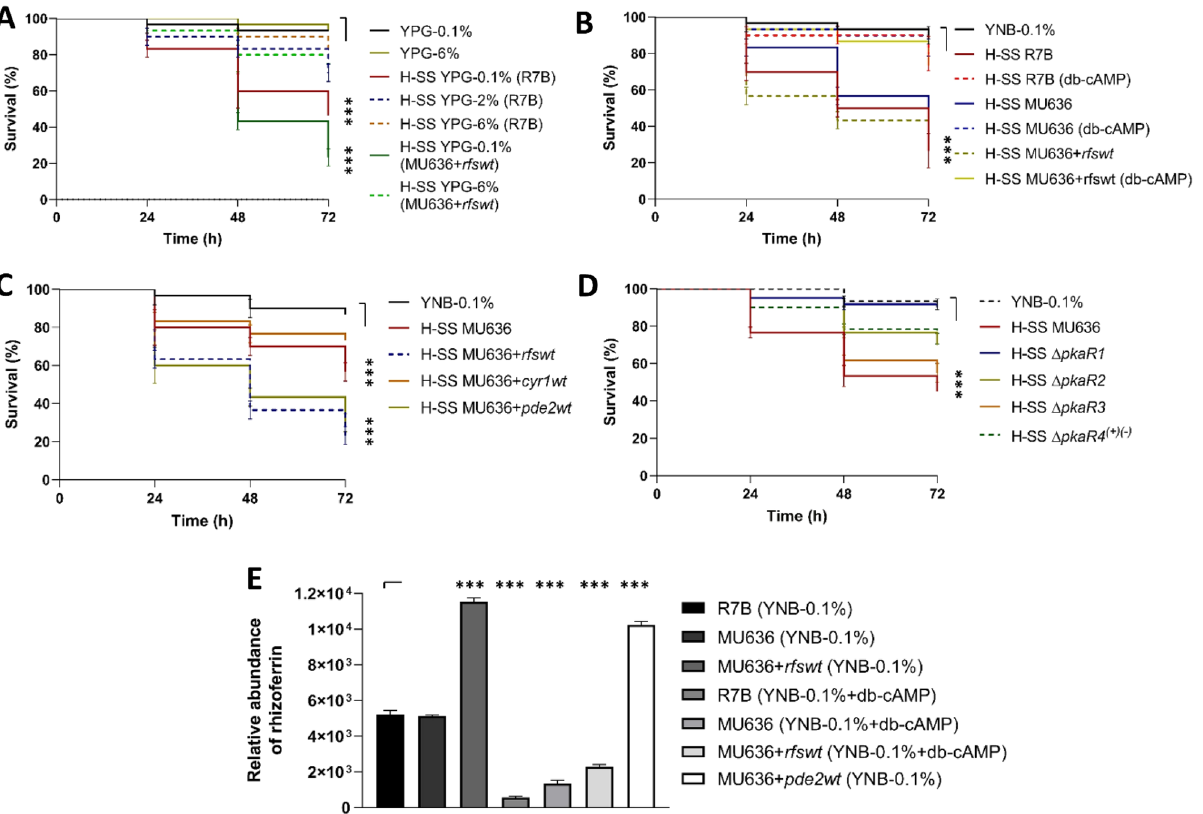
Figure 8. Involvement of the cAMP-PKA pathway in the regulation of rfs , accumulation of rhizoferrin, and virulence of M. lusitanicus . ( A ) Effect of YPG supplemented with 0.1%, 2%, 4%, and 6% glucose (YPG-0.1%, YPG-2%, YPG-4%, and YPG-6%) on the virulence of the cell-free supernatant of the culture (SS) obtained from R7B- and rfs -overexpression (MU636 + rfswt ) strains. ( B ) Effect of the SSs of MU636, R7B, and rfs - overexpression (MU636 + rfswt ) strains obtained after aerobic growth (H-SS) in YNB containing 0.1% glucose (YNB-0.1%) in the presence or absence of 3 mM dibutryril cAMP (db-cAMP) on Caenorhabditis elegans . ( C ) Effect of SSs of adenylyl cyclase 1 ( cyr1 )- and phosphodiesterase 2 ( pde2 )-overexpressing M. lusitanicus on C. elegans . ( D ) Effect of SSs obtained under the aerobic growth of different M. lusitanicus mutants of the regulatory subunit of PKA on C. elegans survival. The results presented are the average of the values obtained from four independent experiments. Data were statistically analyzed using the Mantel-Cox test. *** P < 0.01. When results were not considered significant, we did not provide an additional indication ( P > 0.05). ( E ) Quantification of rhizoferrin in the SSs obtained after the aerobic growth of R7B in YNB-0.1%, MU636, and rfs -overexpression (MU636 + rfswt ) in the absence or presence of 3 mM db-cAMP, or MU636 overexpressing phosphodiesterase 2 ( pde2 ). Significance testing was performed using ANOVA with Fisher’s exact test, * P < 0.05; ** P < 0.01; *** P <